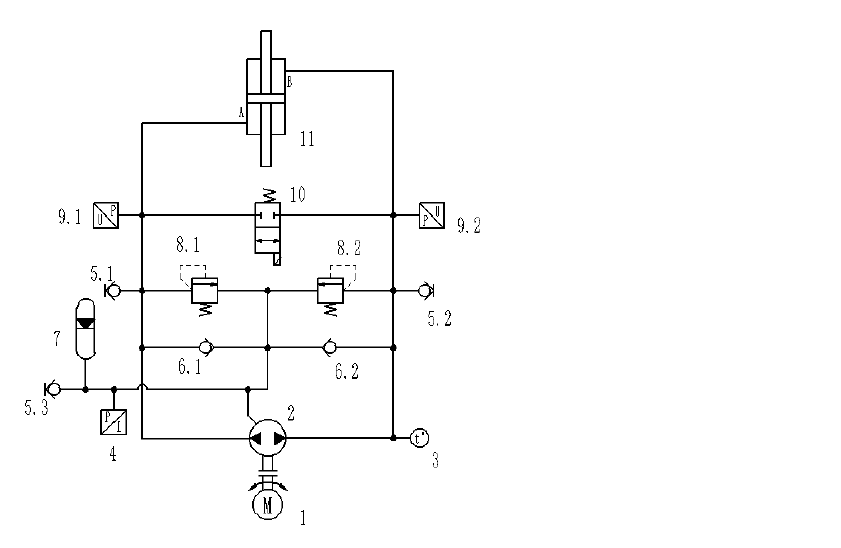
Figure 1. Hydraulic schematic diagram of the DDVC system: 1—servo motor; 2—constant-displace- ment pump; 3—temperature sensor; 4—pressure relay; 5—pressure-measuring connector; 6—check valve; 7—oil-replenishing accumulator; 8—high-pressure relief valve; 9—pressure sensor; 10—un- loading valve; 11—symmetric hydraulic cylinder.